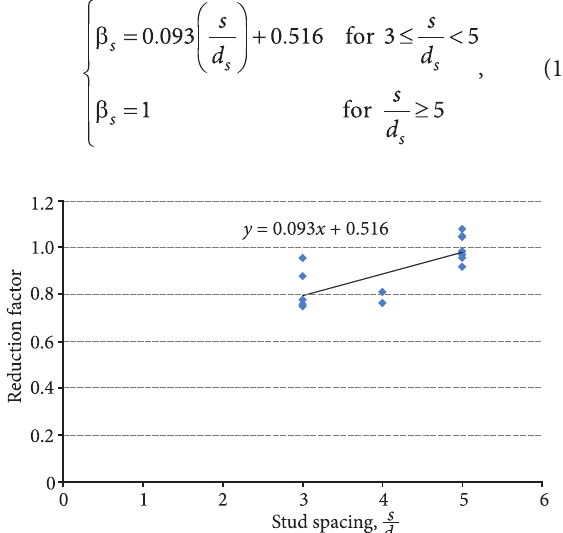
Fig. 8. Results of the statistical